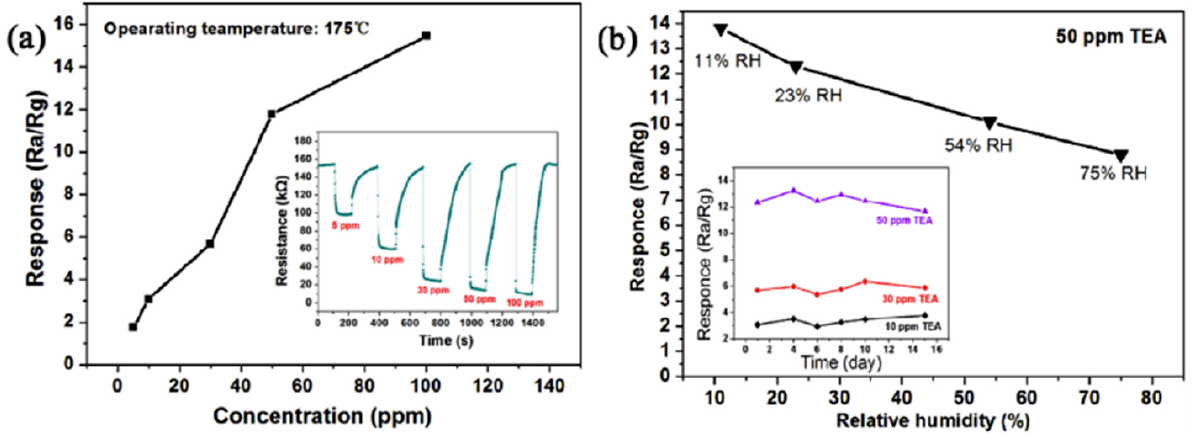
: Ho 3+ nanoparticles. The inset is the SAED image of 0.45 2 : Ho 3+ nanoparticles [88].